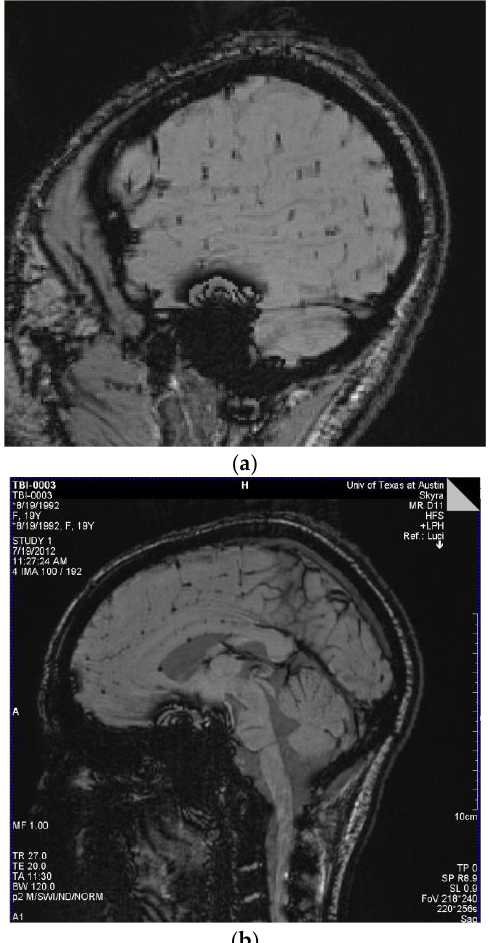
Figure 3. ( a ) Players 29 and 16: Susceptibility-weighted imaging (SWI) demonstrating multiple small areas of signal loss in the base of the sulci. Paramagnetic compounds including deoxyhemoglobin, ferritin, and hemosiderin from the hemorrhages distort the magnetic field resulting in the signal loss. These images are consistent with a primary site of vascular injury and bleed into the brain parenchyma at the base of the sulci; ( b ) SWI Image of Player 12 demonstrating multiple small areas of signal loss in the base of the sulci. Paramagnetic compounds including deoxyhemoglobin, ferritin and hemosiderin from the hemorrhages distort the magnetic field resulting in the signal loss.